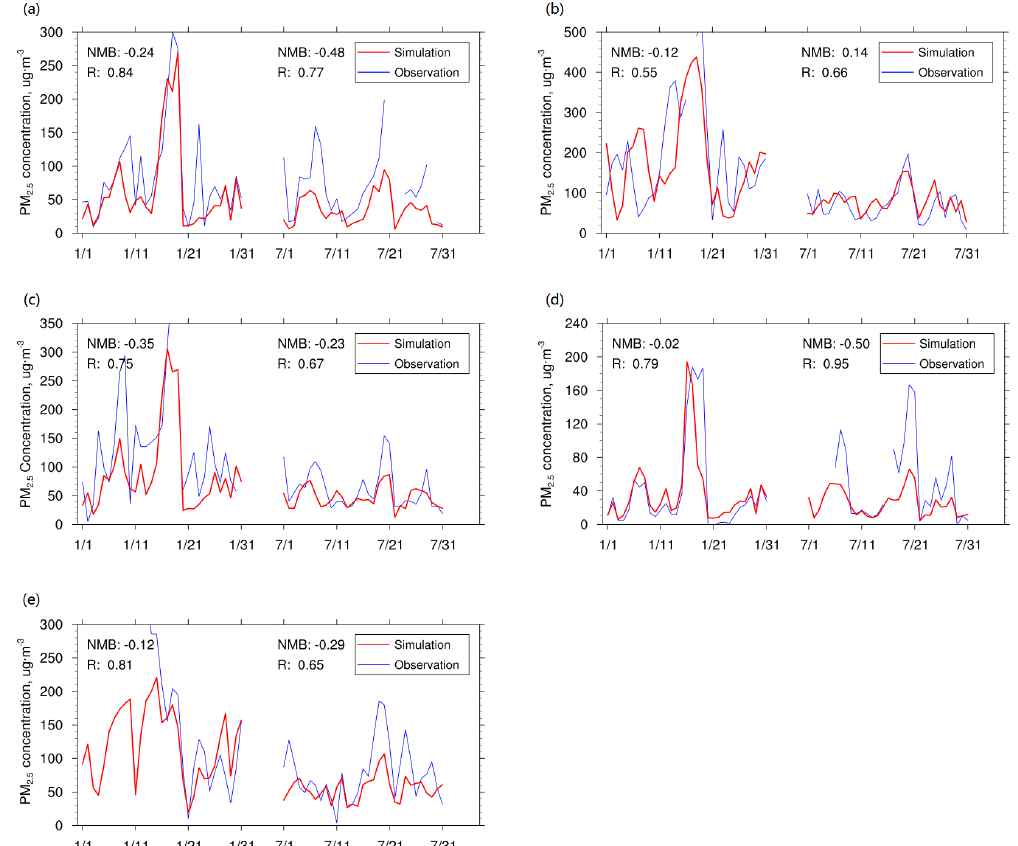
Figure 2. Time series of the simulated and observed PM 2 . 5 concentrations in (a) Beijing, (b) Shijiazhuang, (c) Xianghe, (d) Xinglong and (e)